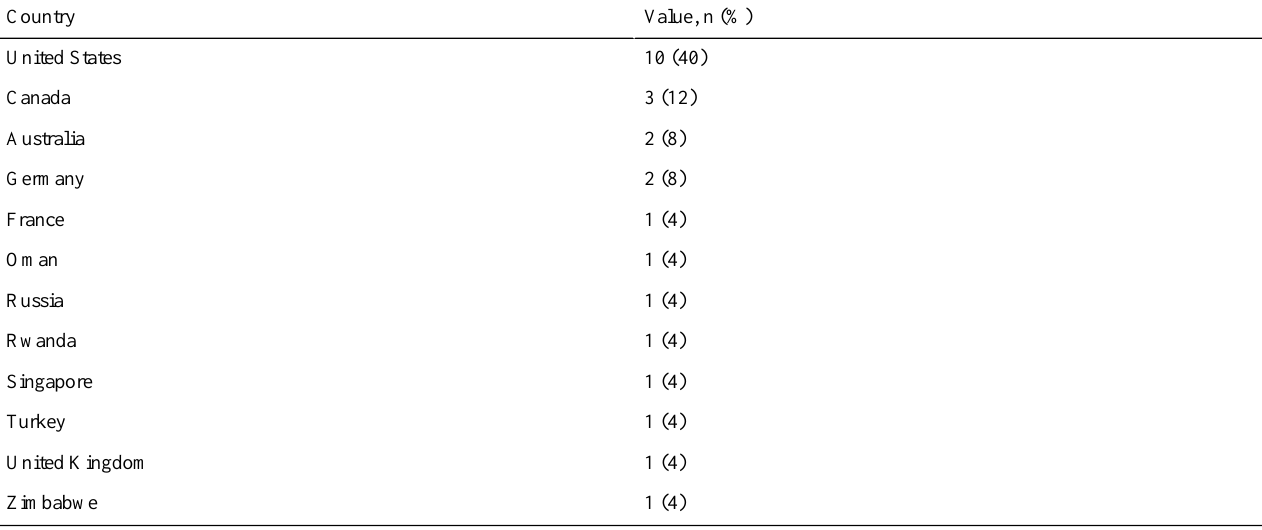
Table 1. Number of studies by study